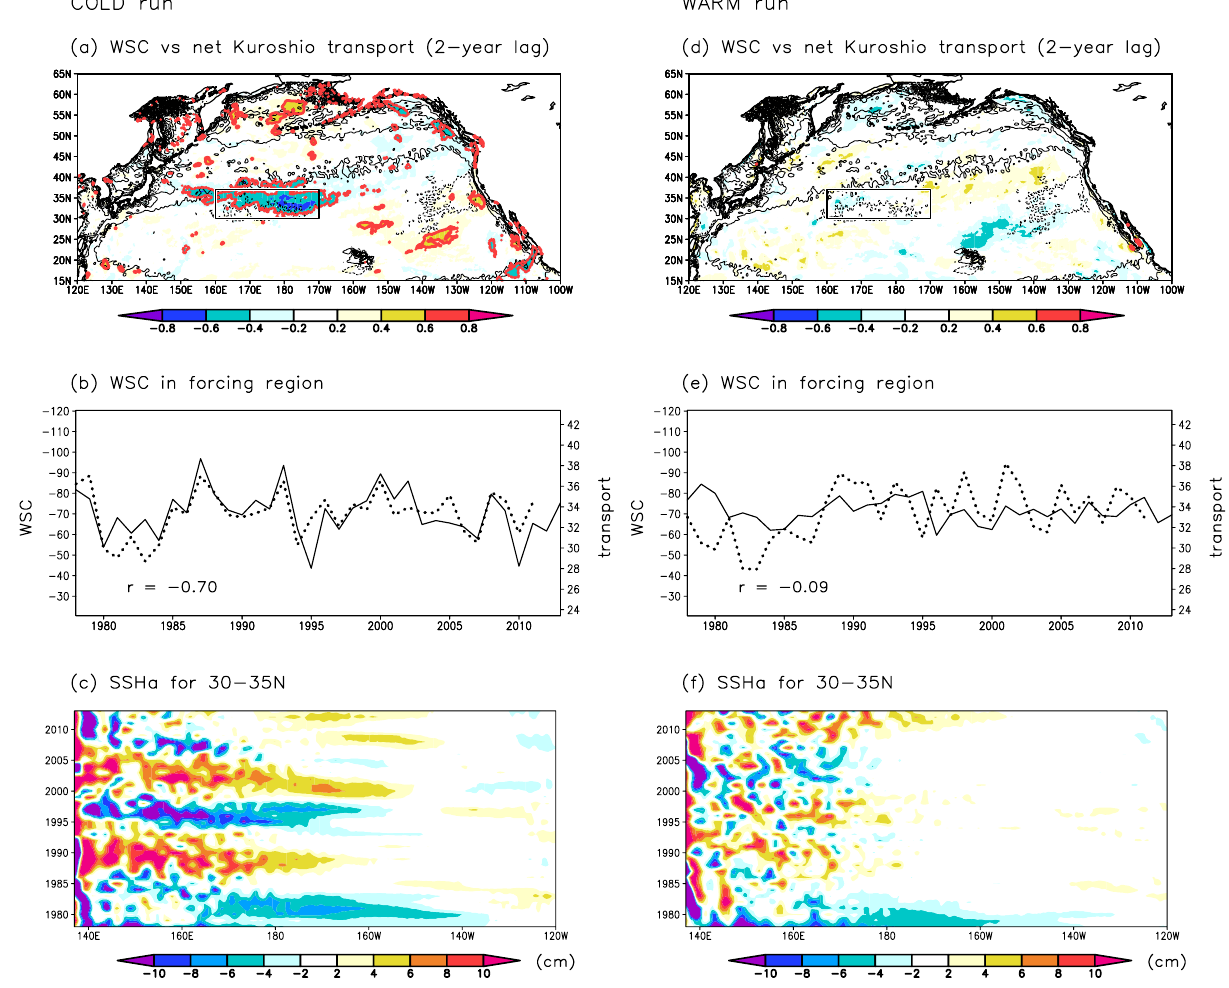
Figure 5. Relationship between the net Kuroshio transport and WSC fields in the North Pacific in the COLD and WARM runs. Same as Fig. 3, but for the ( a – c ) COLD and ( d – f ) WARM runs.